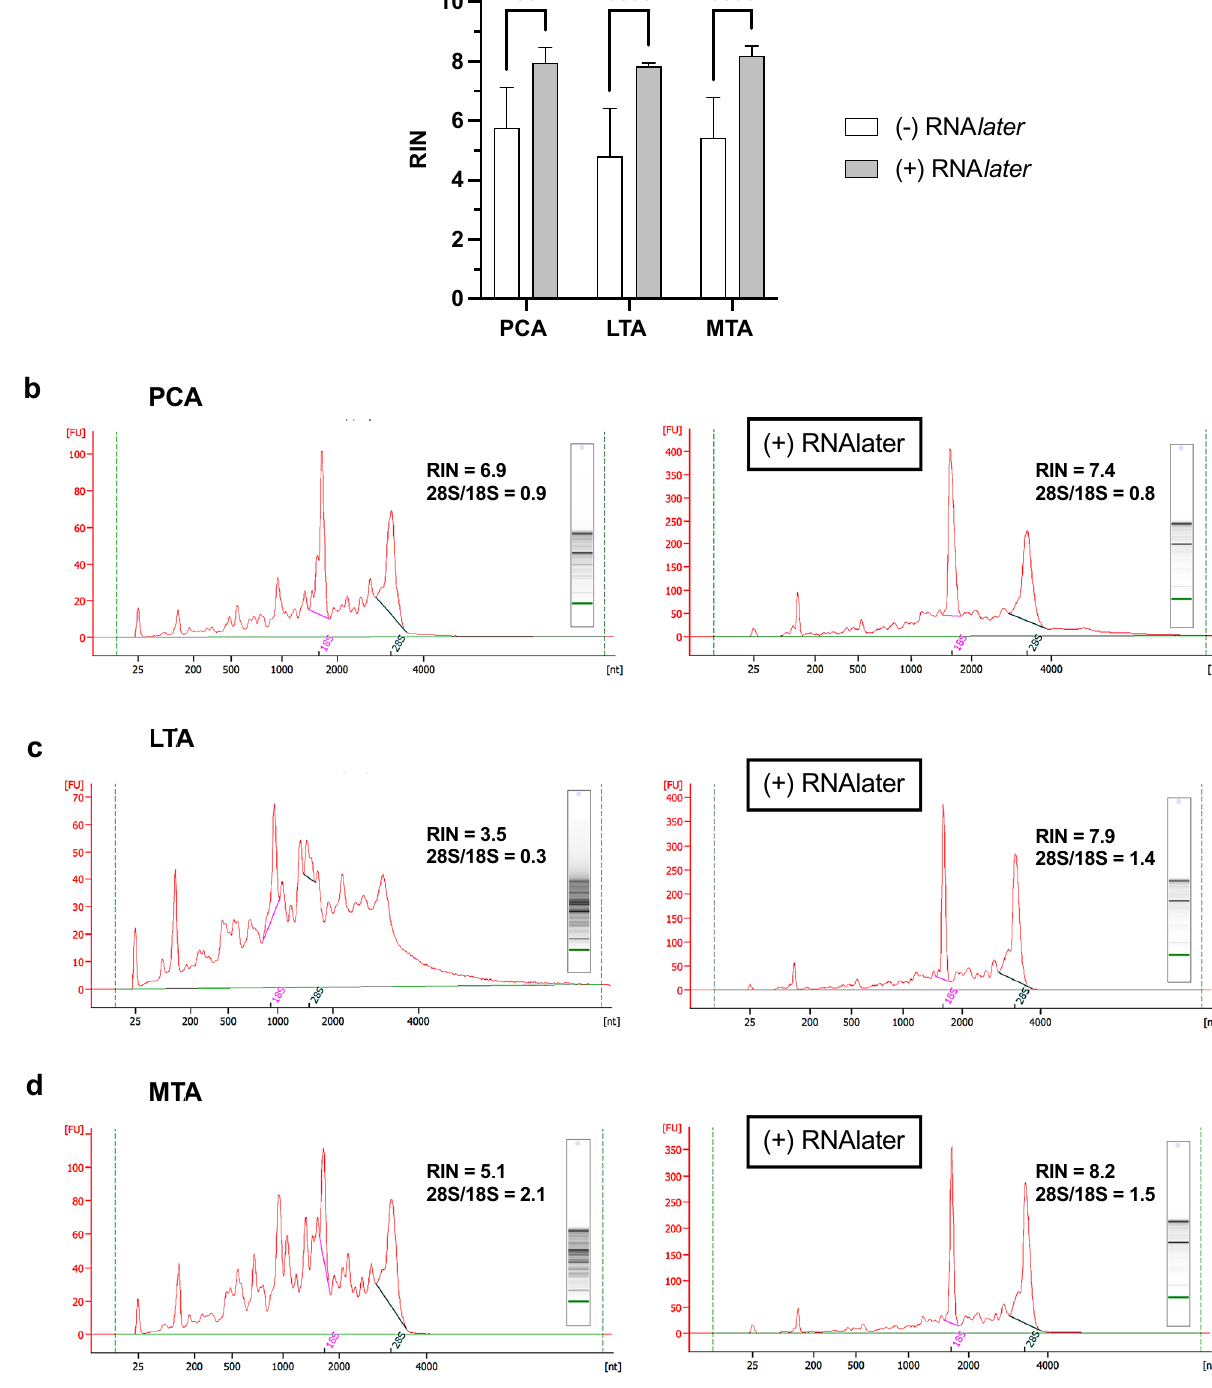
Figure 2. Comparison of RNA stability under standard conditions and following experimental application of RNase-inhibiting reagent (RNA later ). ( a ) Significant differences were found in RIN between the experimental (+ RNA later ) (PCA, N = 7; LTA, N = 5; MTA, N = 9) and standard (-RNA later ) methods (PCA, N = 5; LTA, N = 6; MTA, N = 6). ( b – d ) Electropherograms from the standard ( left ) are juxtaposed with the experimental method ( right ). Electropherograms provided by Agilent 2100 Bioanalyzer Pico Chip were visualized using 5 µL total RNA. Electrophoretic traces, RIN, 28S/18S ratios, and gel electropherograms that were representative of the global results are displayed for the PCA ( b ), LTA ( c ), and MTA muscles ( d ). 28S ribosomal peaks are shown in magenta, and 18S ribosomal peaks are shown in green. Analysis of variance was performed using a two- way ANOVA with Posthoc tests. The data is expressed as mean ± SD. * means P < 0.05; ** P < 0.01; *** P < 0.001; **** P < 0.0001. Original gels are presented in Supplementary Fig.